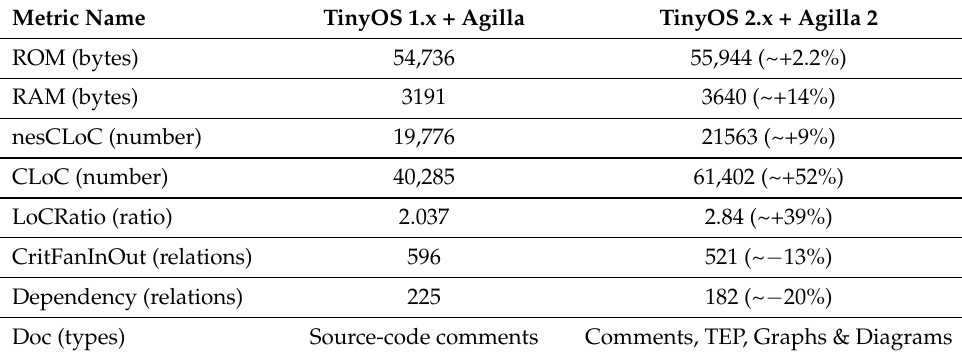
Table 5. Metrics evaluation results (MICAz